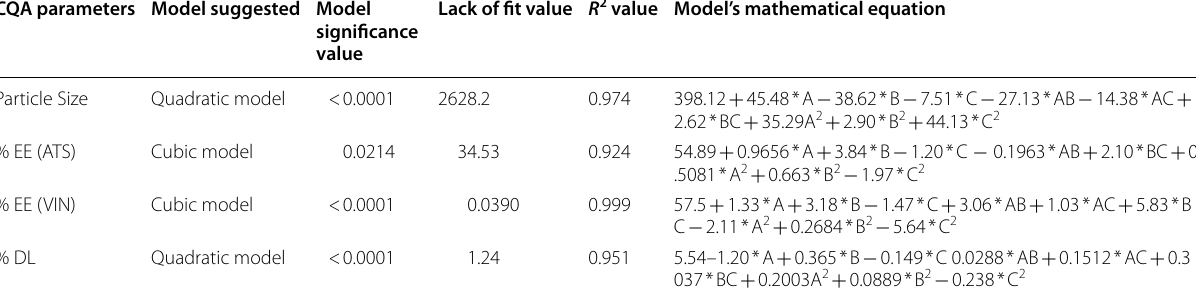
Table 5 Model analysis and model fitted statistical values CQA parameters Model suggested Model